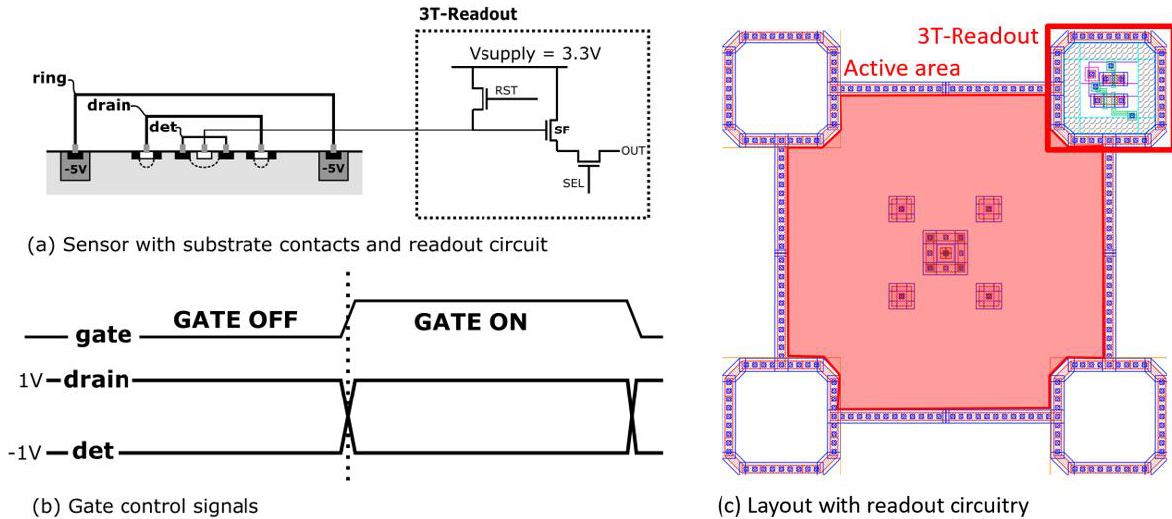
Figure 15. Typical operation of a CAPS sensor showing the sensor substrate contacts and 3T readout circuit ( a ) and gating control signals ( b ). The layout of the CAPS sensor with readout circuitry is shown in ( c ).